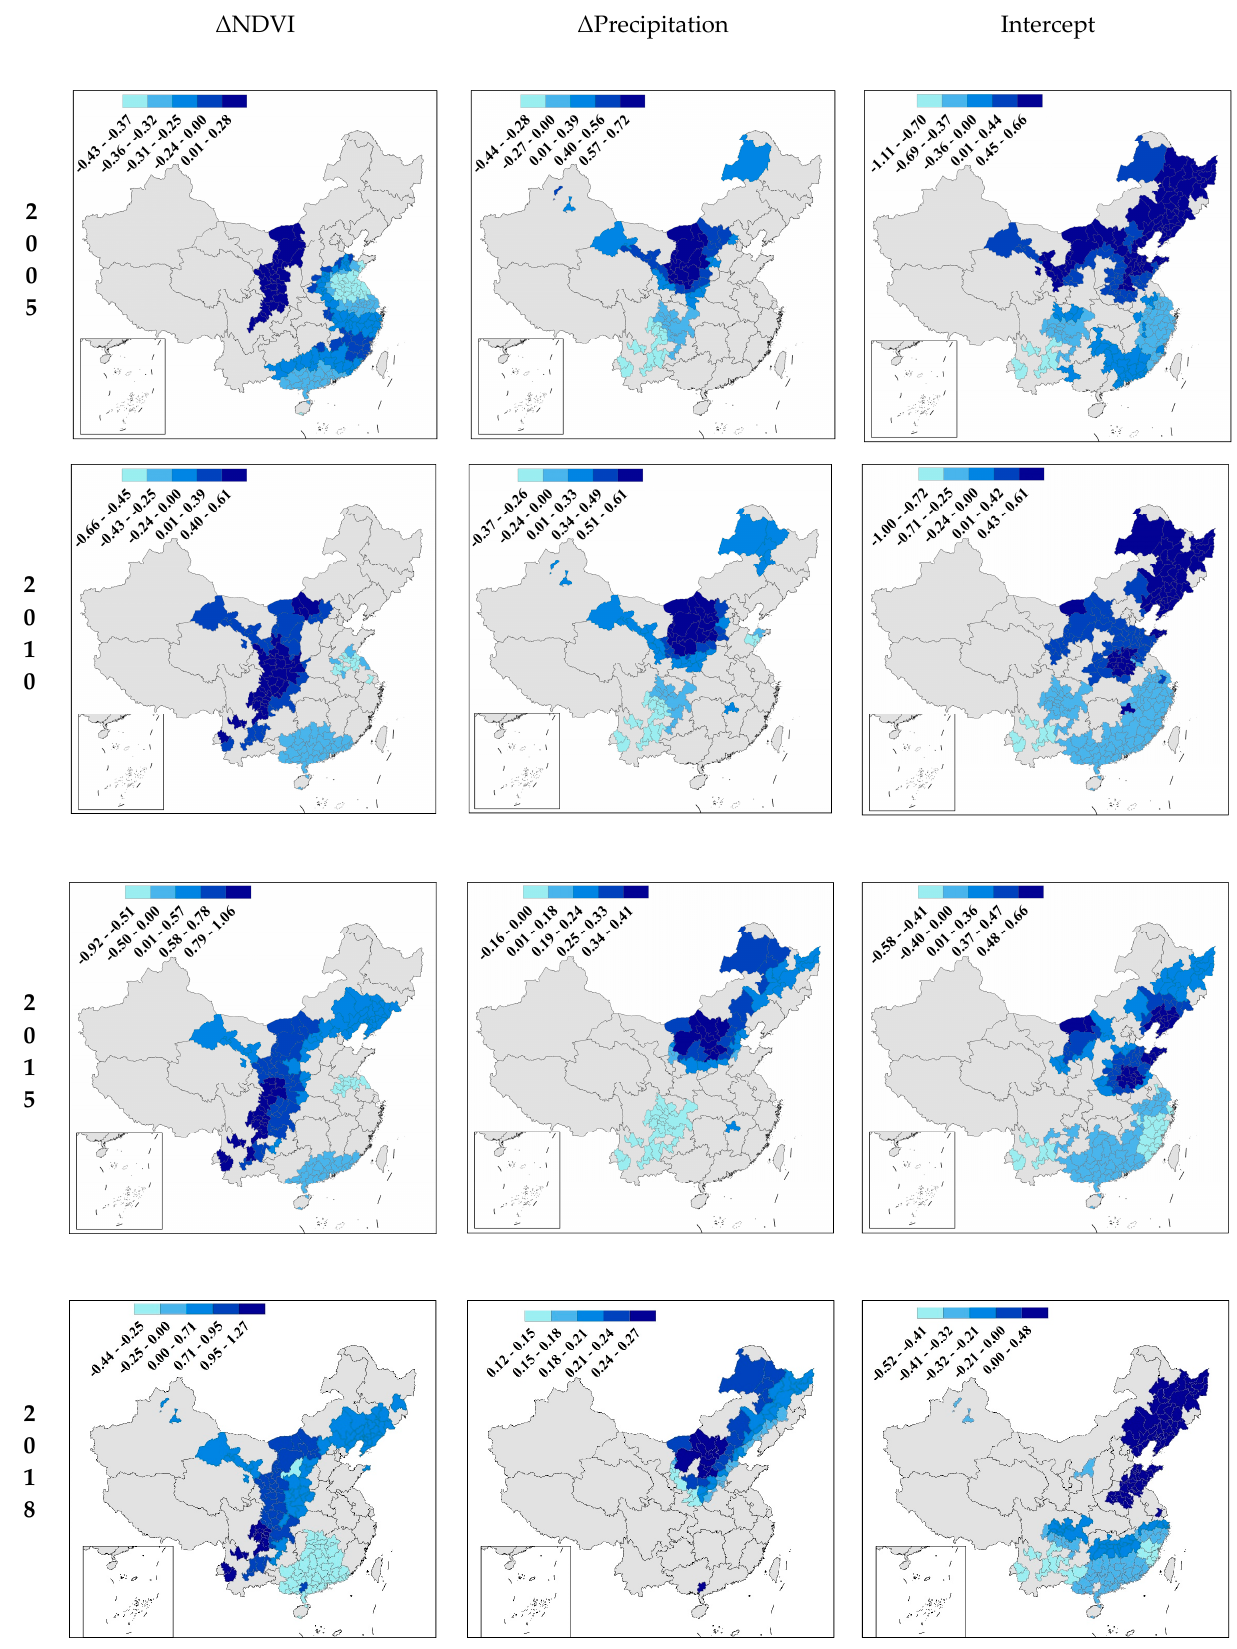
Figure 6. Spatial distributions of the coefficients of ∆ NDVI, ∆ Precipitation, Intercept for the nighttime MGWR model in 2005, 2010, 2015, and 2018.